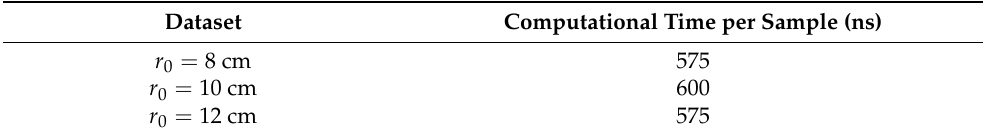
Table 4. Means of the computational time needed by the MLP model per sample for each test dataset.